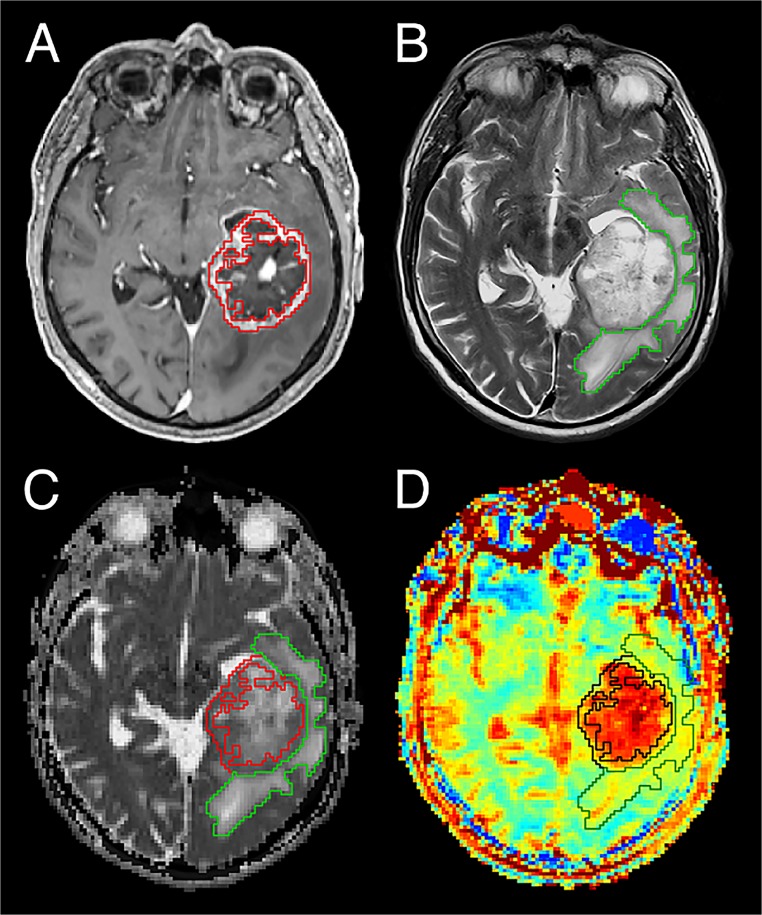
Segmentation of the regions of interest (ROI) CE-T1 tumor and T2 peritumoral edema.Glioblastoma of the left temporal lobe in patient 6. Coregistered images from the different sequences showing an exemplary slice of the whole tumor volume for this patient. A) CE-T1 tumor ROI (red line) segmented on CE T1-weighted image while thoroughly excluding central necrosis. B) T2 peritumoral edema ROI (green line) segmented on T2-weighted image. C) Coregistered ADC map and D) MTRasym contrast illustrating both ROIs. The glioblastoma tumor and the cerebrospinal fluid in sulci and ventricles display hyperintense on NOE mediated CEST based on MTRasym.